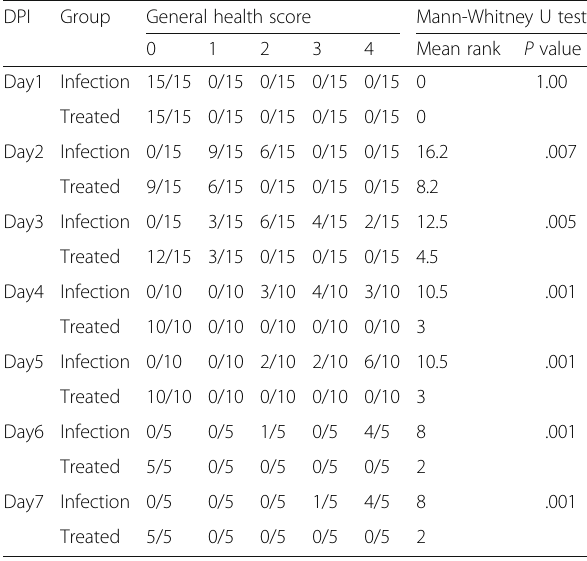
Table 2 Comparison of GHS of LM infected and LB + LM treated group